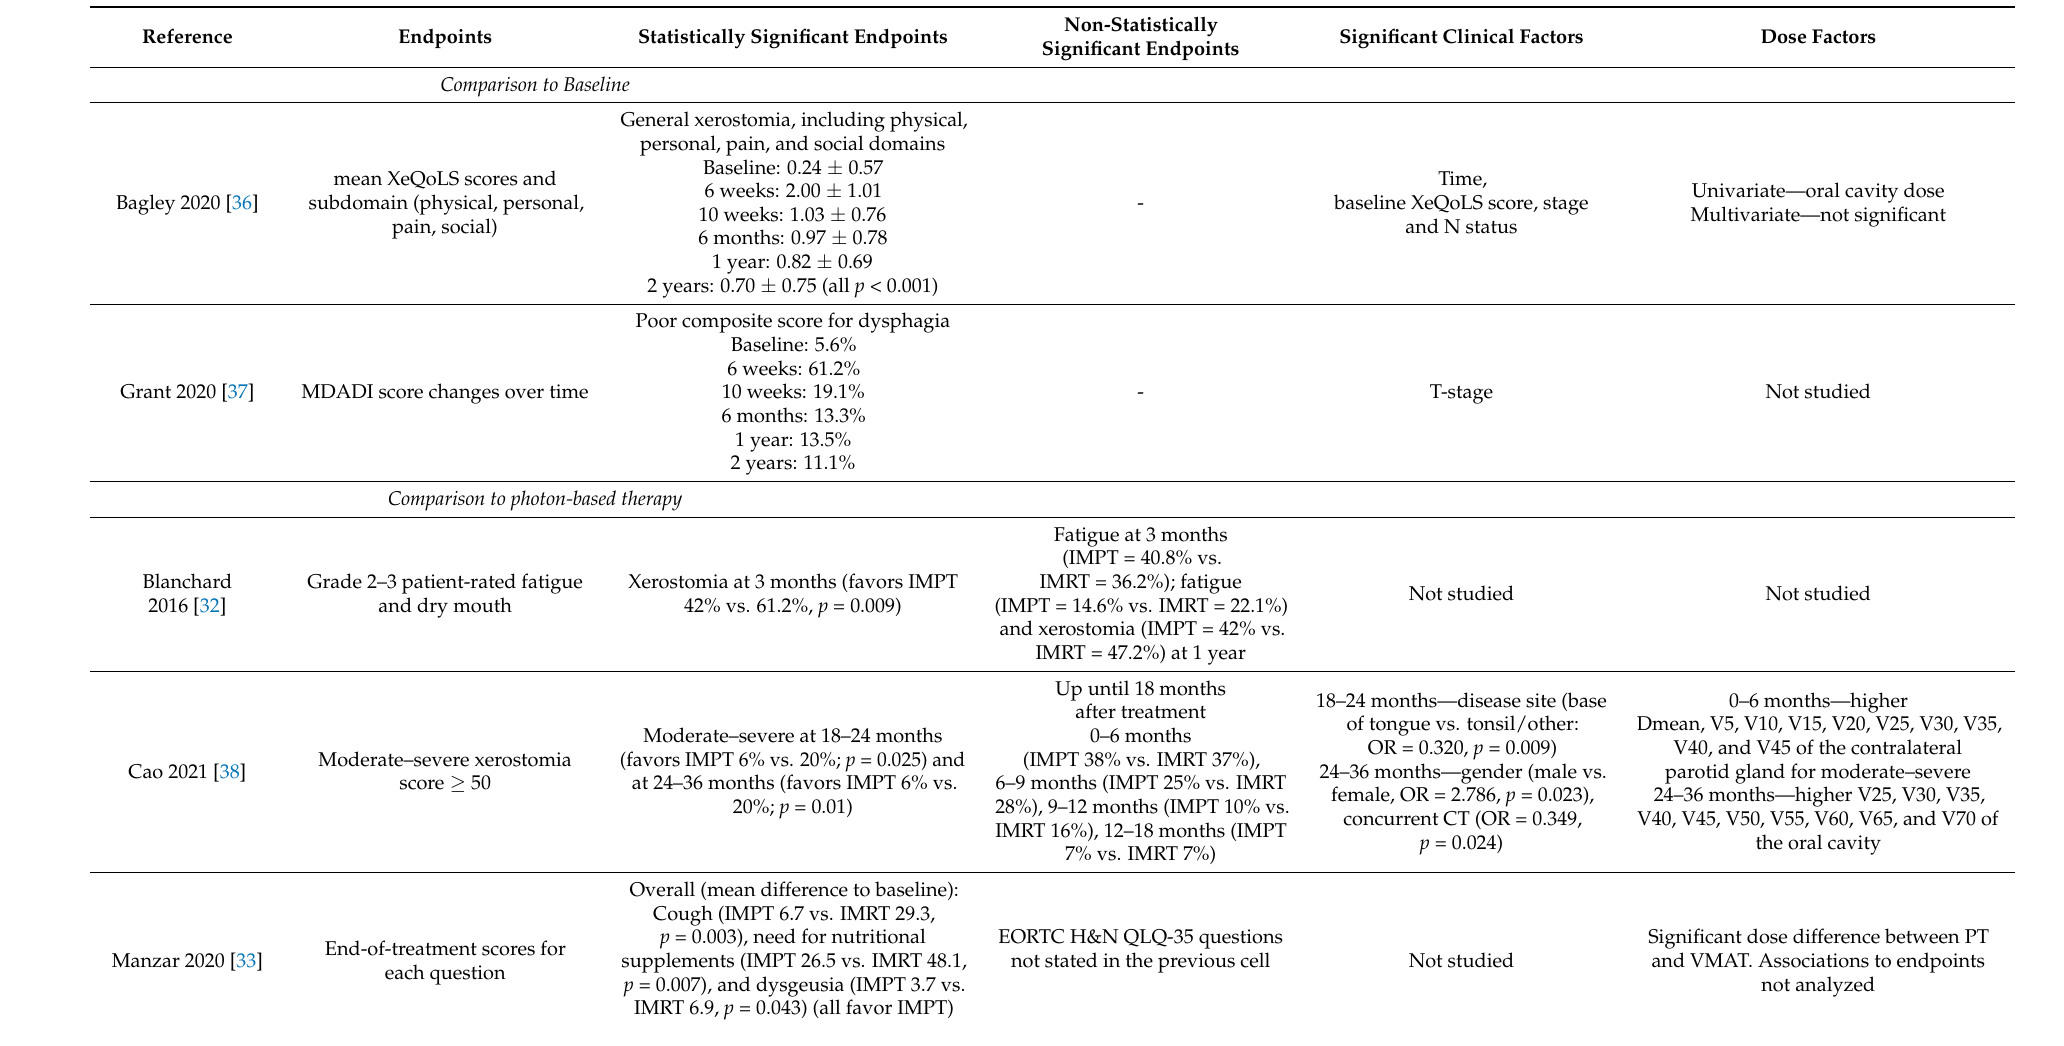
Table 3. Significant endpoints and significant factors impacting